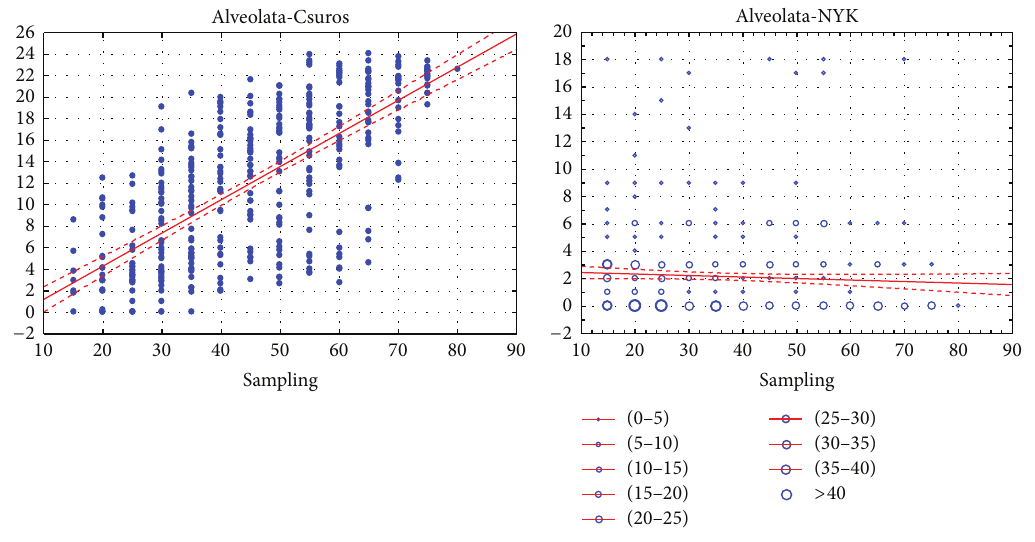
Figure 3: Examples of sampling size-intron density correlation patterns inferred by the Csuros (left) and NYK (right) algorithms. Horizontal axis: number of species in the sampling. Vertical axis: inferred intron density at the node (introns/kb). Note that NYK returns estimations of ancestral intron count rounded down to integers, therefore bubble diagram was used. Bubble size represents number of data points at the same scatterplot